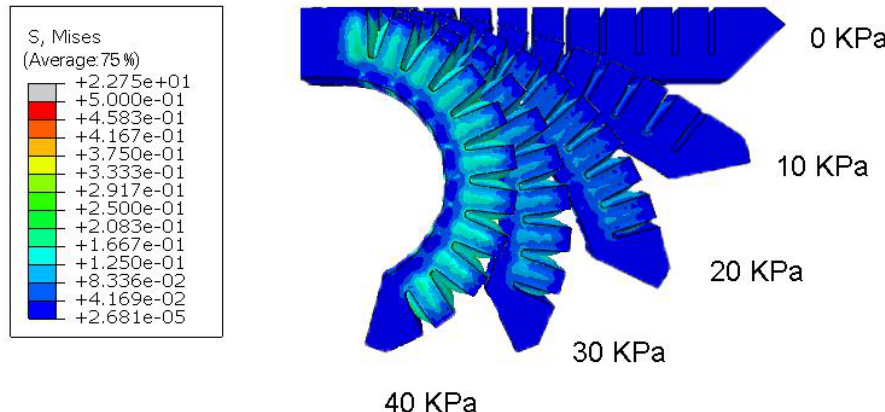
Figure 10. Deformed shape of the finger with stress contour under different air pressure.